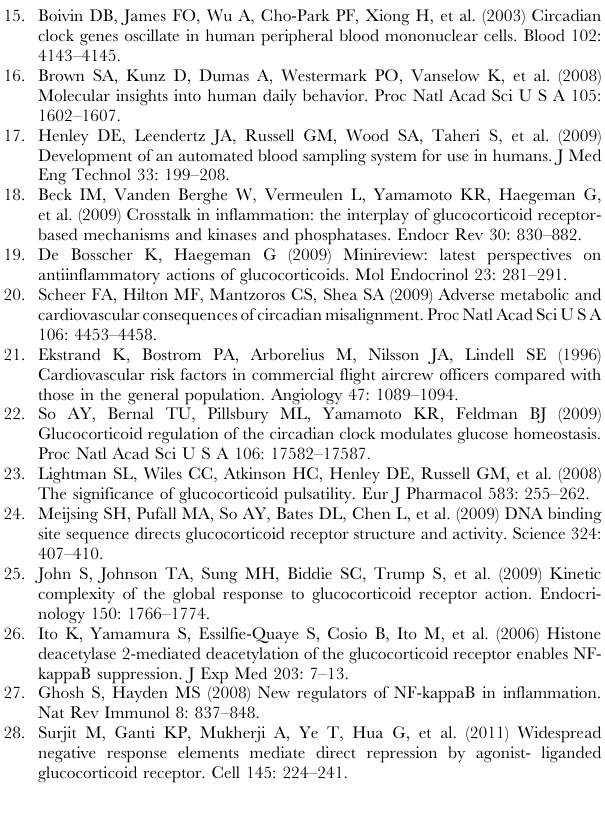
evaluation of the mRNA expressions of the known glucocorticoid- responsive genes indicated. Annexin A1 and GILZ are known to be up-regulated by glucocorticoids, while IFN c and IL-12 p40 are known to be down-regulated. Bars represent the mean 6 S.E. values of hydrocortisone (HC)-induced fold mRNA expression of indicated genes. **: P , 0.01, compared to the conditions indicated (m= 3). B: mRNA expressions of known glucocorticoid-responsive genes in the morning and the evening. Relative mRNA expressions of annexin A1 , GILZ , IFN c and IL-12 p40 at 8 am (Day) and 8 pm (Night) in PMBCs obtained from 10 healthy subjects are shown. Bars represent mean 6 S.E. values of relative mRNA expression of the genes indicated. **: P , 0.01, n.s.: not significant, compared to the conditions indicated (n= 10, m =20). (TIF) Figure S2 Time-dependent alteration of hydrocortisone-stimu- lated annexin A1 mRNA expression ex vivo . PBMCs obtained at 6 am from 6 healthy subjects were cultured in the medium and were treated with 5 6 10 2 7 M of hydrocortisone (HC) for 3 hours at every 6 hours. mRNA levels of annexin A1 were then determined. Experiments were performed with duplicate in each subject. Circles represent the mean 6 S.E. values of hydrocortisone (HC)- induced fold mRNA expression of annexin A1 . Values obtained in the absence of hydrocortisone (HC) at time ‘‘0’’ were employed as